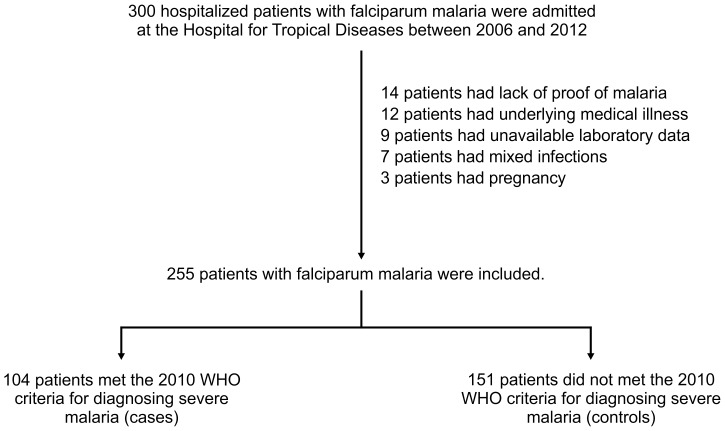
Patient recruitment flow chart.